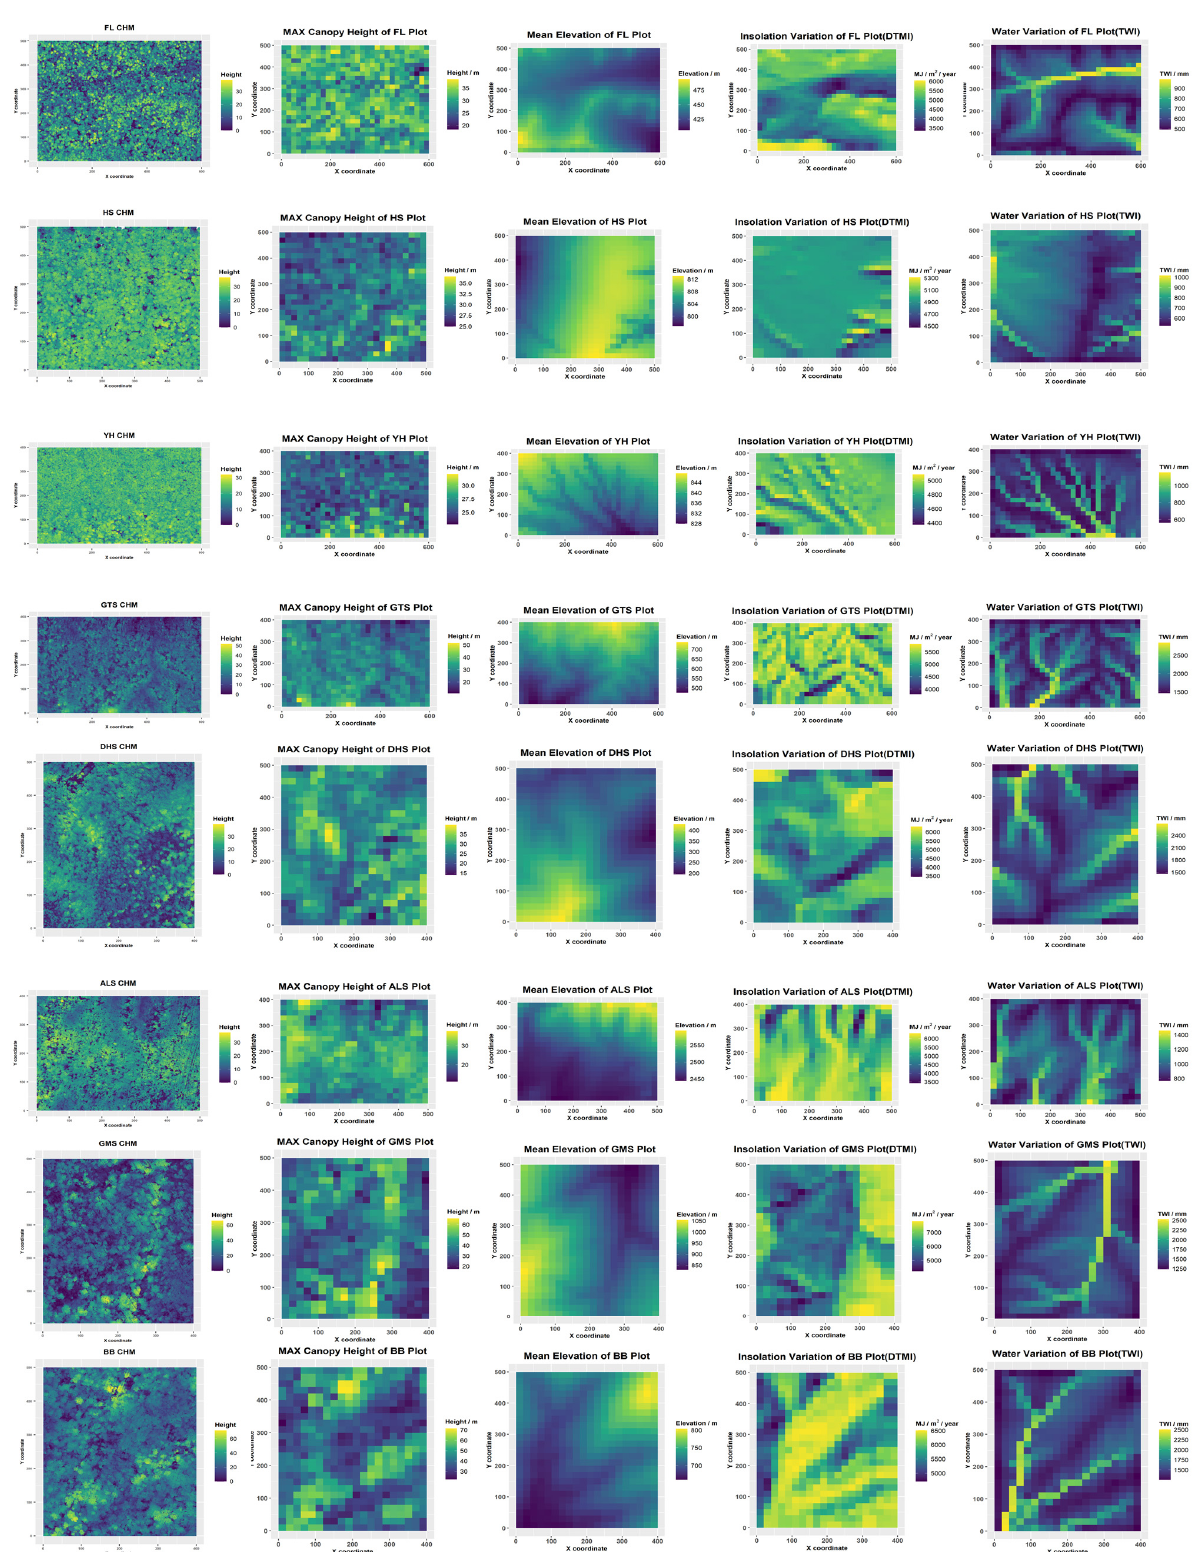
Figure A1. Canopy height model (CHM) at 0.5-meter resolution and Hmax, mean elevation, TWI, and DTMI of each 20 × 20 m quadrat in 8